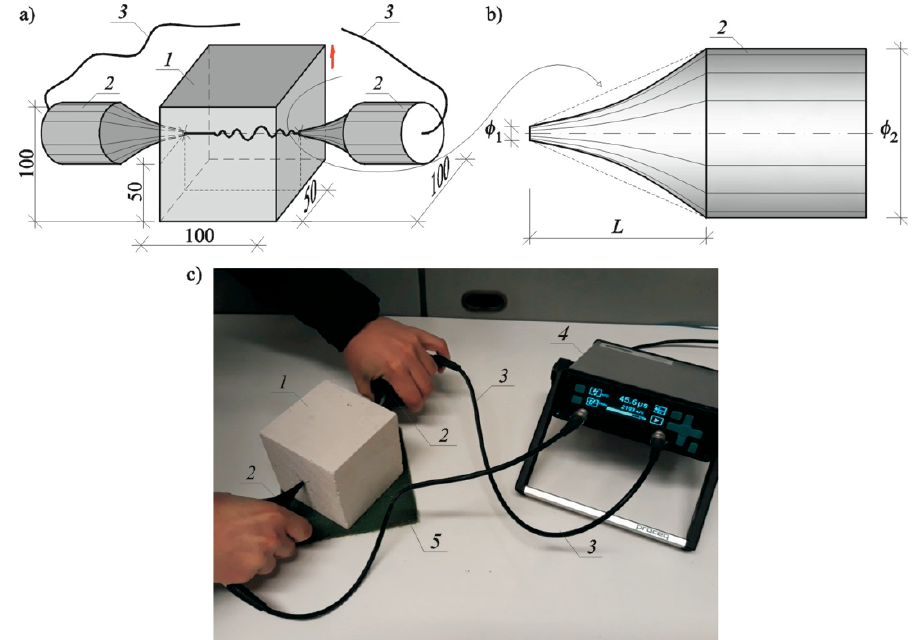
Figure 7 . A test stand for measuring ultrasound velocity: ( a ) specimen geometry and elements of the stand (given in millimeters), ( b ) geometry of exponential transducer, and ( c ) a test stand; 1, tested AAC specimen 100 mm × 100 mm × 100 mm; 2, exponential transducers; 3, cables connecting transducers with recording equipment; 4, recording equipment; and 5, an insulating pad.